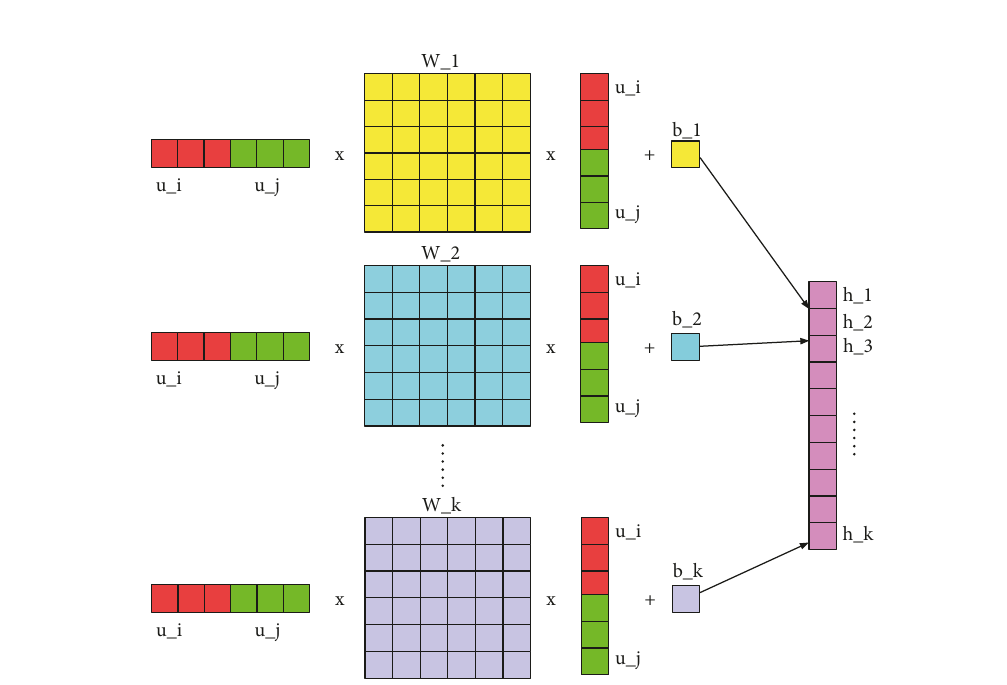
Figure 2: Interaction